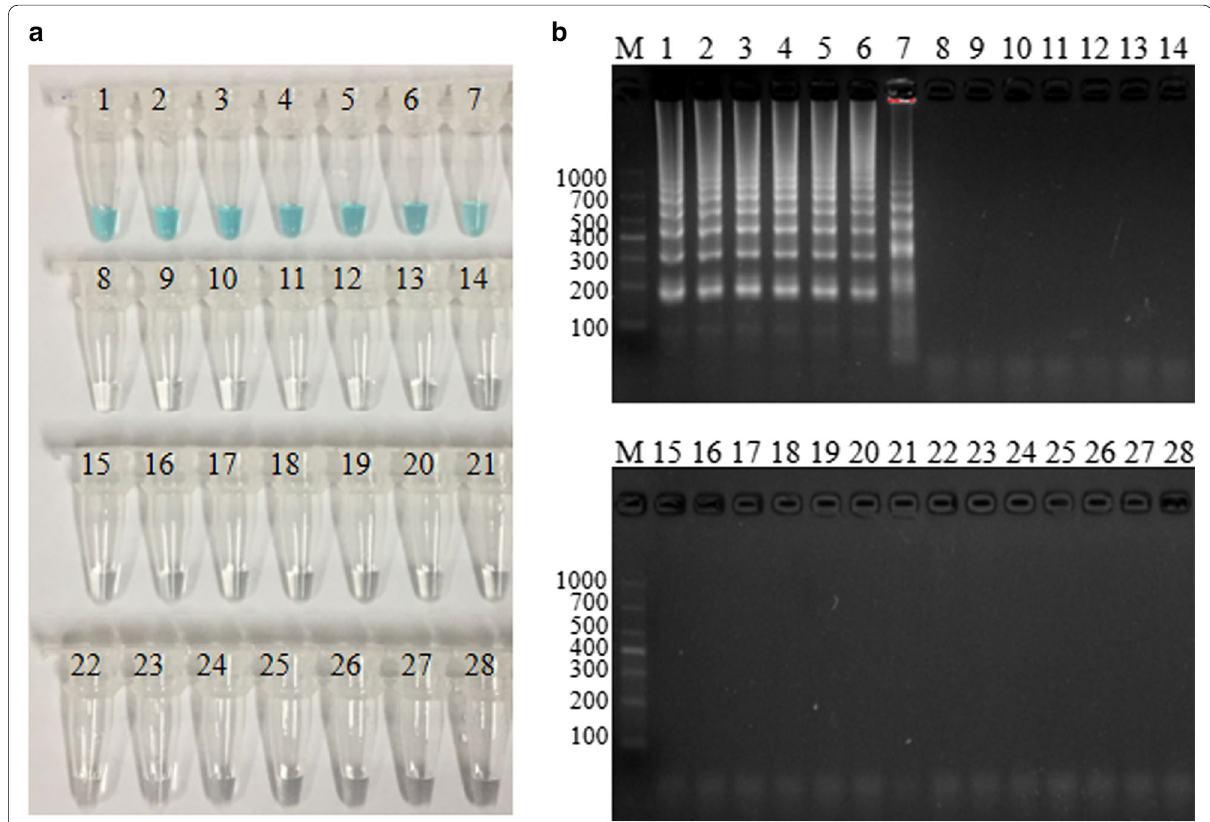
Fig. 6 Specificity analysis. A total of 28 strains were used to evaluate the specificity of MCDA-LFB assays. Light green was visuable for all S treptococcus agalactiae , and colorless was observed for non -Streptococcus agalactiae . 1, Positive control (S treptococcus agalactiae strain ATCC12386), 2–7, Streptococcus agalactiae . 8, Streptococcus pyogenes ; 9, Streptococcus pneumoniae ; 10, Streptococcus mitis ; 11, Streptococcus salivarius ; 12, Streptococcus sanguinis ; 13, Streptococcus dysgalactiae ; 14, Streptococcus gordonii ; 15, Streptococcus sinensis ; 16, Streptococcus constellatus ; 17, Streptococcus anginosus ; 18, Enterococcus faecium ; 19, Enterococcus raffinosus ; 20, Staphylococcus epidermidis ; 21, Staphylococcus saprophyticus ; 22,